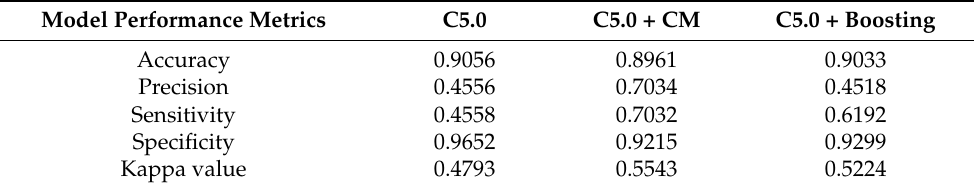
Table 9. C5.0, C5.0 + CM and C5.0 model with added boosting model performance metrics.